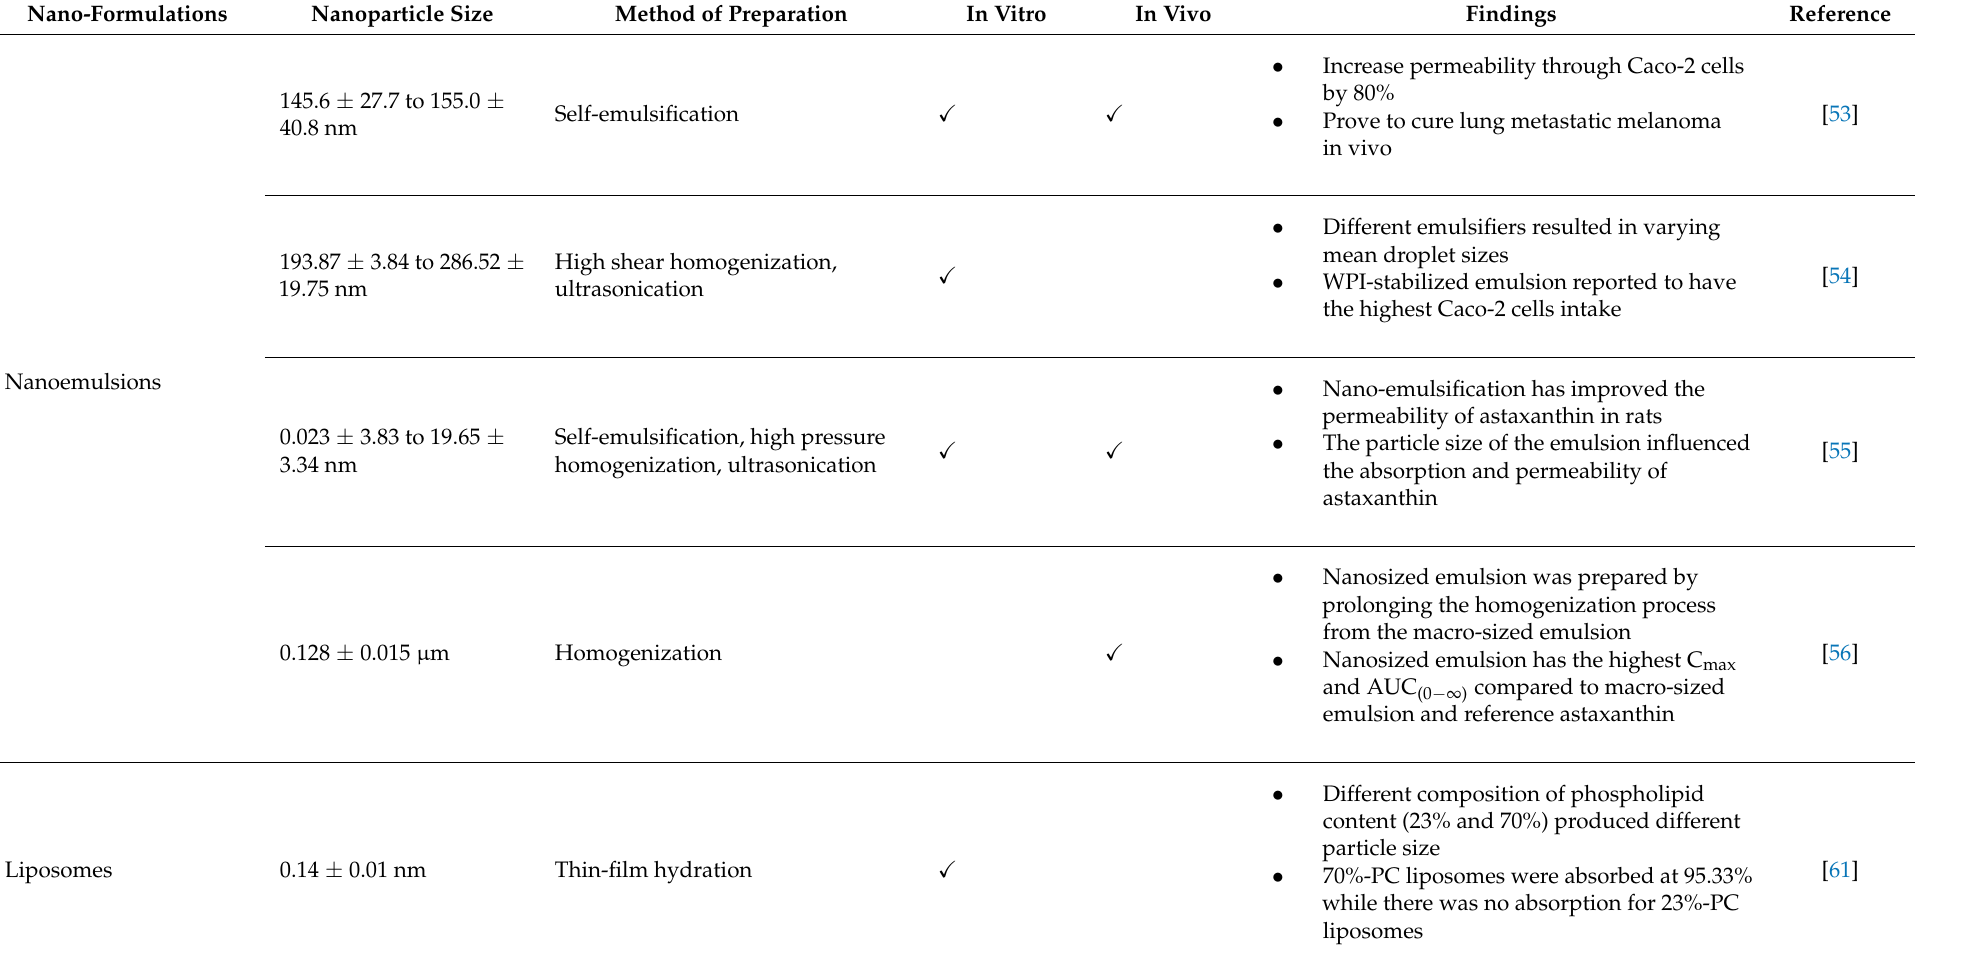
Table 2. Summary findings of astaxanthin